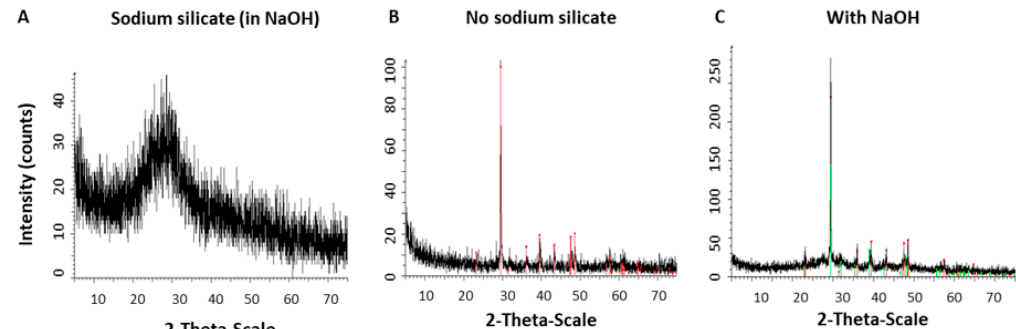
Figure 4. Effect of sodium silicate on the crystal state of the material. ( A , B ) XRD analysis of the particles synthesized with sodium silicate resulted in an amorphous material, while absence of silicate produced the high ordered form of the material, calcite. ( C ) Control, only the solvent of silicate solution was added (NaOH) showing no effect on the material’s crystalline state.